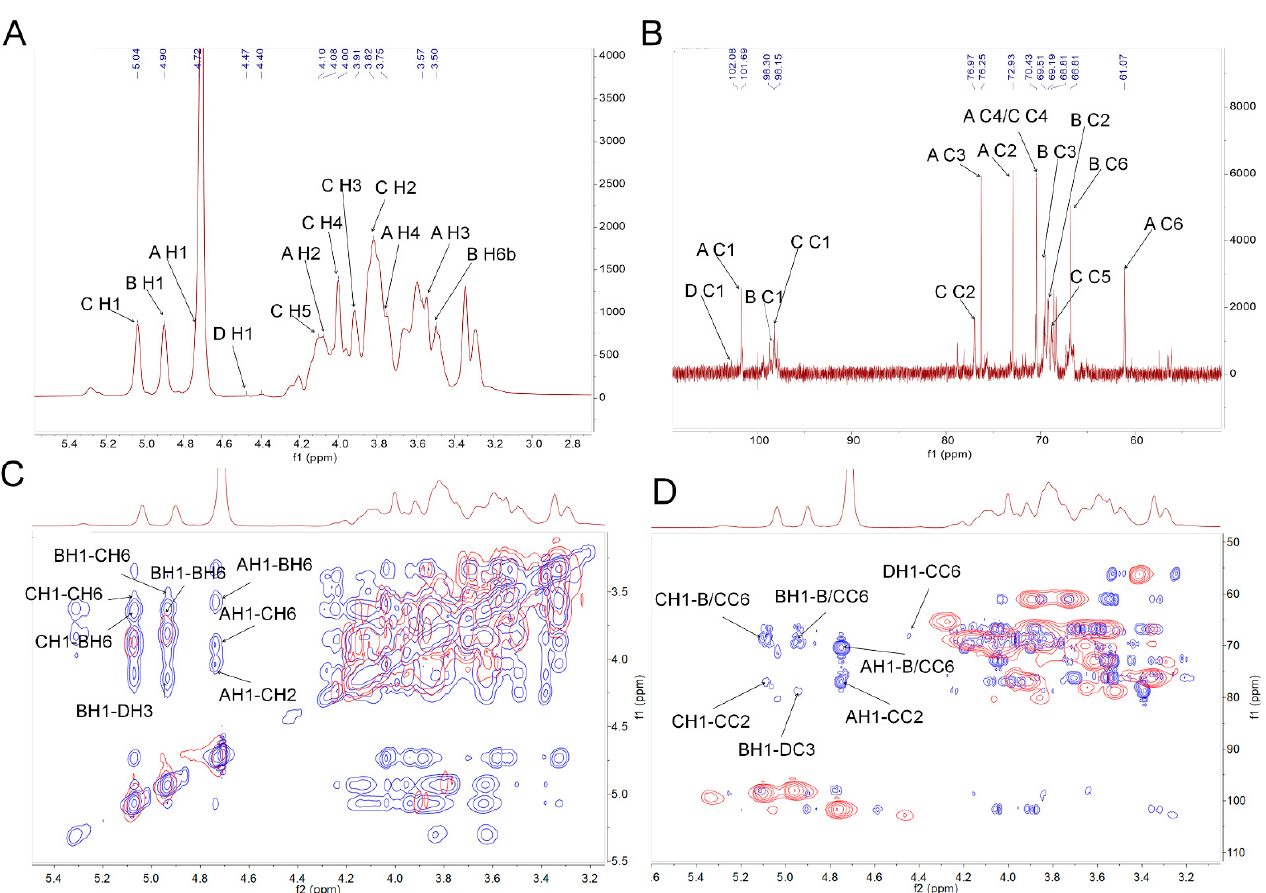
ppm could be assigned to H2-H6a/b (Figure S2A), respectively. The signals of the C1–C6 of residue A could be confirmed according to the cross peaks in the heteronuclear single quantum correlation (HSQC) spectrum (Figure S2B). The results of other residues similar to residue A were also observed. Consistent with the monosaccharide composition and methylation analysis, PAPS1 contained four major residues: β -D-Man p -(1 → (residue A), → 6)- α -D-Gal p -(1 → (residue B), → 2,6)- α -D-Gal p -(1 → (residue C) and → 3)- β -D-Glc p -(1 → (residue D). The proton–proton and proton–carbon single bond correlations were con- firmed by the combined results of COSY and nuclear overhauser effect spectroscopy (NO- ESY) spectrum (COSY-NOESY) (Figure 2C), HSQC and heteronuclear multiple bond cor- relation (HMBC) (HSQC–HMBC) (Figure 2D), respectively. The anomeric proton H-1 of residue C showed a strong cross signal with its H-6 (5.04/3.85 ppm) (Figure 2C) and its C- 6 (5.04/66.78 ppm) (Figure 2D), indicating the presence of 2, 6C1 → 6, 2C1. In addition, the H-1 of residue C also had strong cross signals with the C-6 (5.04/66.82 ppm) of residue B, which indicated the presences of 2, 6C1 → 6B1. The H-1 of residue B had a strong cross